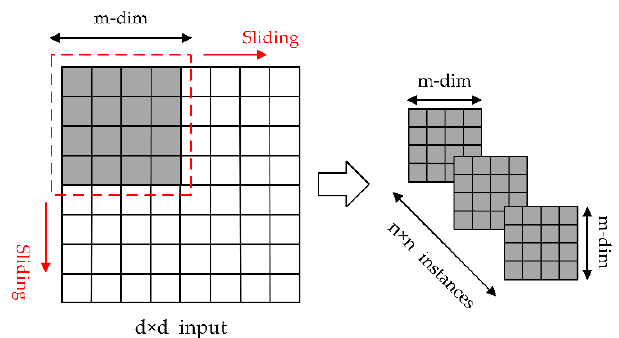
Figure 1. The process of extracting the original image features by sliding the pane.